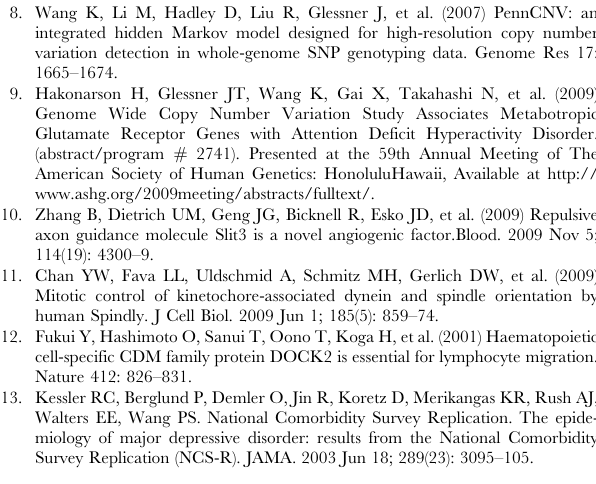
Table S1 Specific phenotypes of the 5 MDD cases with the duplication of the SLIT3 locus to evaluate